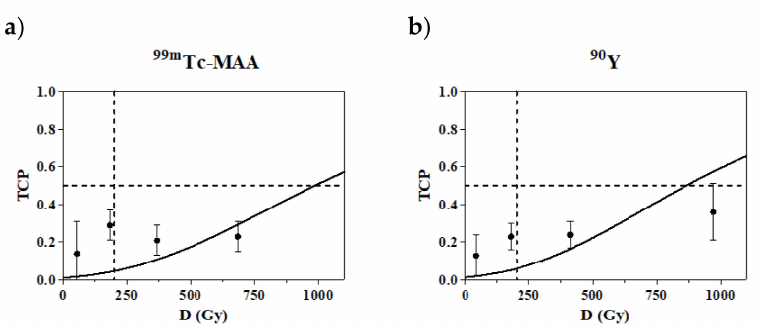
Figure 7. The Poisson model-fitting curves for the 99m Tc-MAA SPECT ( a ) and 90 Y-PET ( b ) Tumour Control Pobability (TCP) curves (Equation (5)) with Complete Response (CR) as endpoint. Lesions with CR were the same with the two methods. The dashed lines are only a grid to improve visual comparison between different